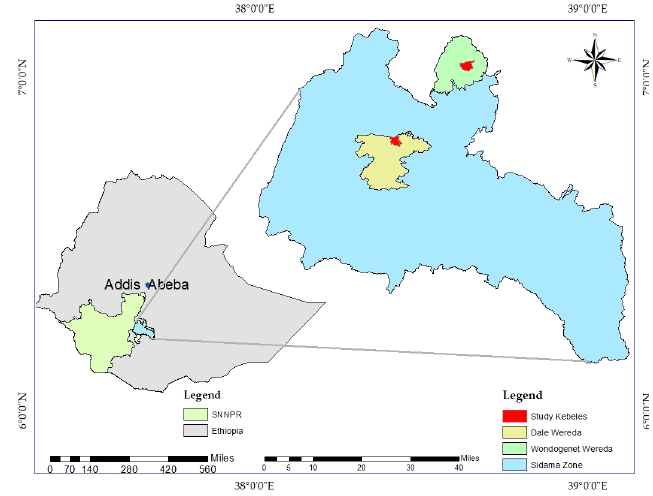
Figure 1. Map of the study areas.